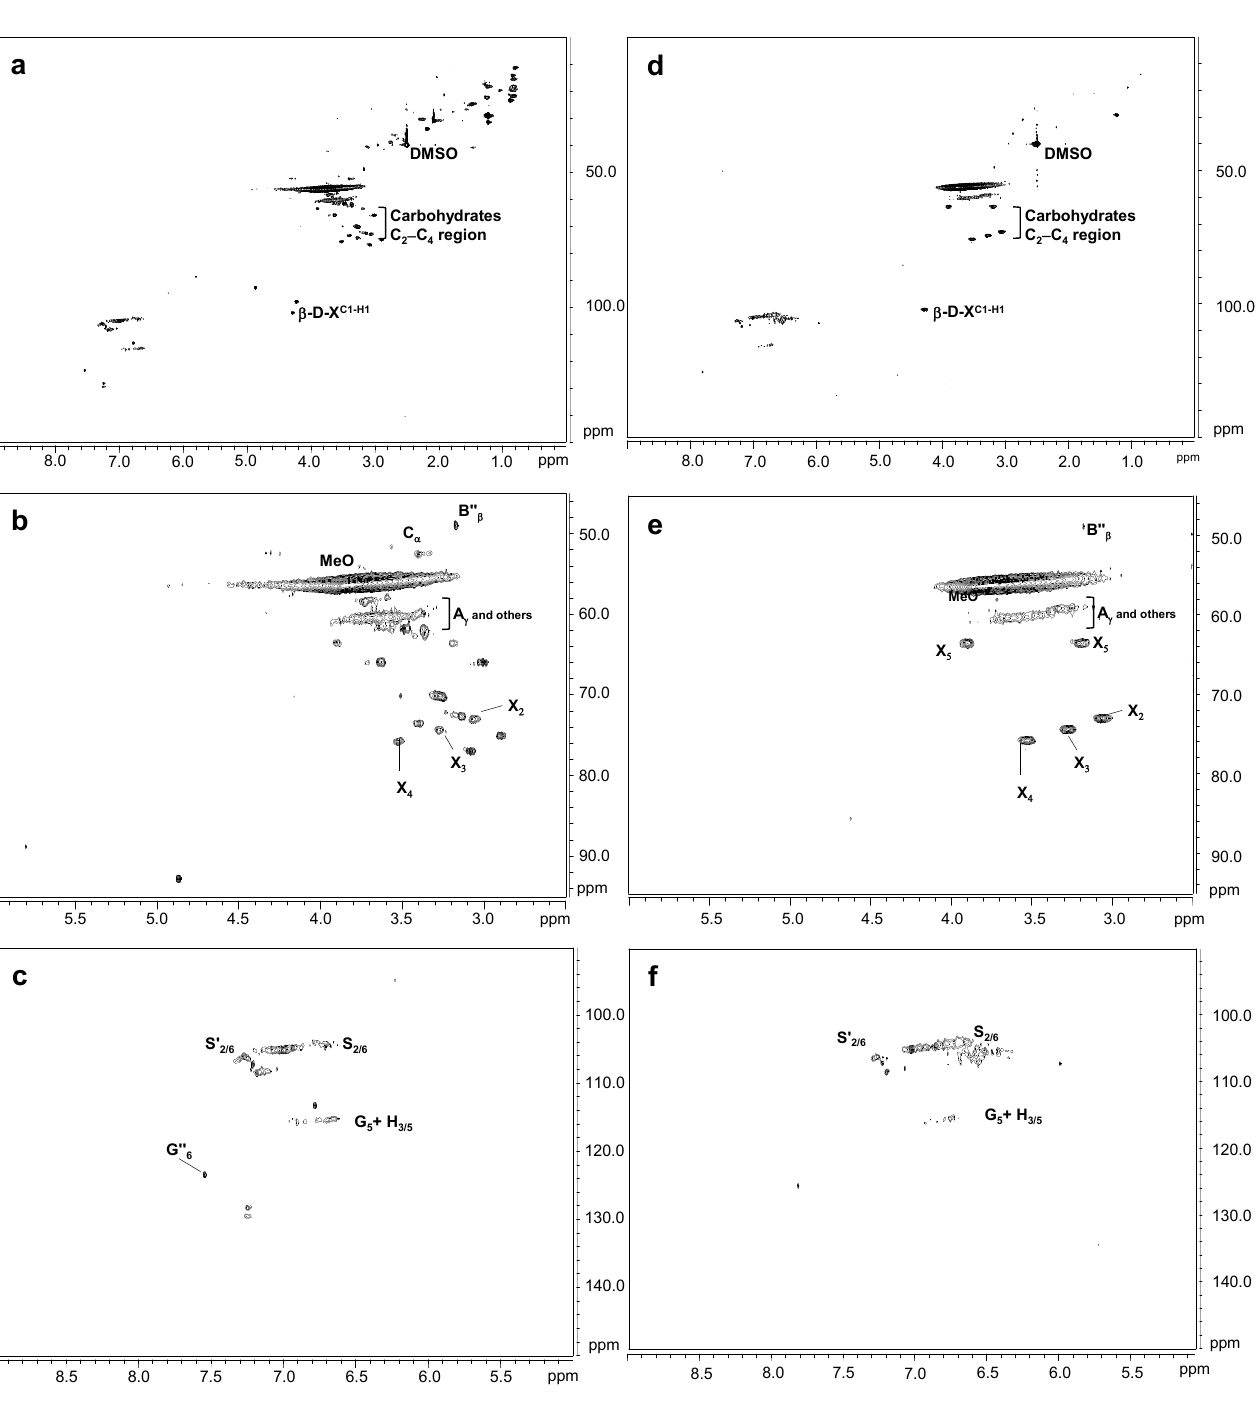
Figure 4. HSQC 2D-NMR spectra of laccase-treated Kraft lignins. Whole spectrum, δ C / δ H Figure 4. HSQC 2D ‐ NMR spectra of laccase ‐ treated Kraft lignins. Whole spectrum, δ C / δ H 0.0– 150.0/0.0–9.0, for SiLA ‐ KL1 ( a ) and MtL ‐ KL1 ( d ); aliphatic oxygenated region, δ C / δ H 45.0–95.0/2.5– 0.0–150.0/0.0–9.0, for SiLA-KL1 ( a ) and MtL-KL1 ( d ); aliphatic oxygenated region, δ C / δ H 6.0 ppm, for SiLA ‐ KL1 ( b ) and MtL ‐ KL1 ( e ); aromatic region, δ C / δ H 90.0–150.0/5.0–9.0 ppm, for 45.0–95.0/2.5–6.0 ppm, for SiLA-KL1 ( b ) and MtL-KL1 ( e ); aromatic region, δ C / δ H 90.0–150.0/ SiLA ‐ KL1 ( c ) and MtL ‐ KL1 ( f ). 5.0–9.0 ppm, for SiLA-KL1 ( c ) and MtL-KL1 ( f